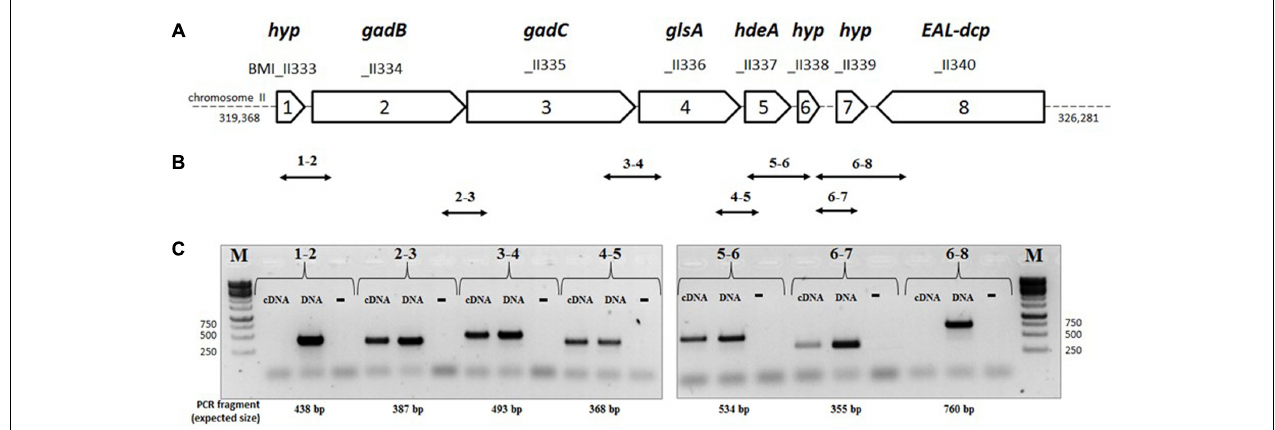
FIGURE 2 | Organization of the genes of the gadB/C–glsA locus of B. microti CCM4915. (A) Map of the gad - EAL-dcp region: each arrow represents an ORF, with the reported length proportional to its size on chromosome II of B. microti . Gene name: gadB (Glu decarboxylase), gadC (Glu/GABA antiporter), glsA (glutaminase), hdeA (chaperone protein HdeA), EAL - dcp (EAL- d omain c ontaining p utative protein). The corresponding locus designations (locus tags) are shown above each arrow. (B) Double-headed arrows indicate the positions and sizes of the expected intergenic PCR fragments. (C) Agarose gel electrophoresis of the RT-PCR products. For each pair of primers, indicated by pair of numbers, three separate PCR reactions were performed using as template cDNA (test reaction), genomic DNA (“DNA,” positive control), and not-reverse transcribed RNA of B. microti (“ − ”, negative control). M = 1 kb DNA ladder (Euromedex). The sizes of relevant ladder bands are shown on the left and on the right of each panel,